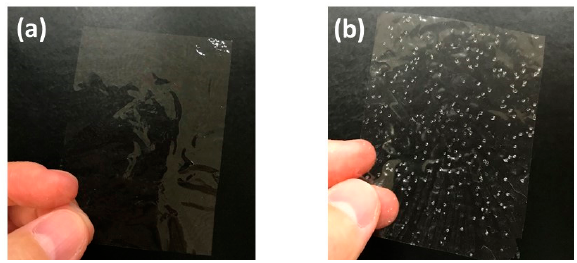
Figure 1. Appearance of transparent cellulose nanopaper prepared using evaporation drying at ( a ) 50 °C for 12 h and ( b ) 110 °C for 2 h.